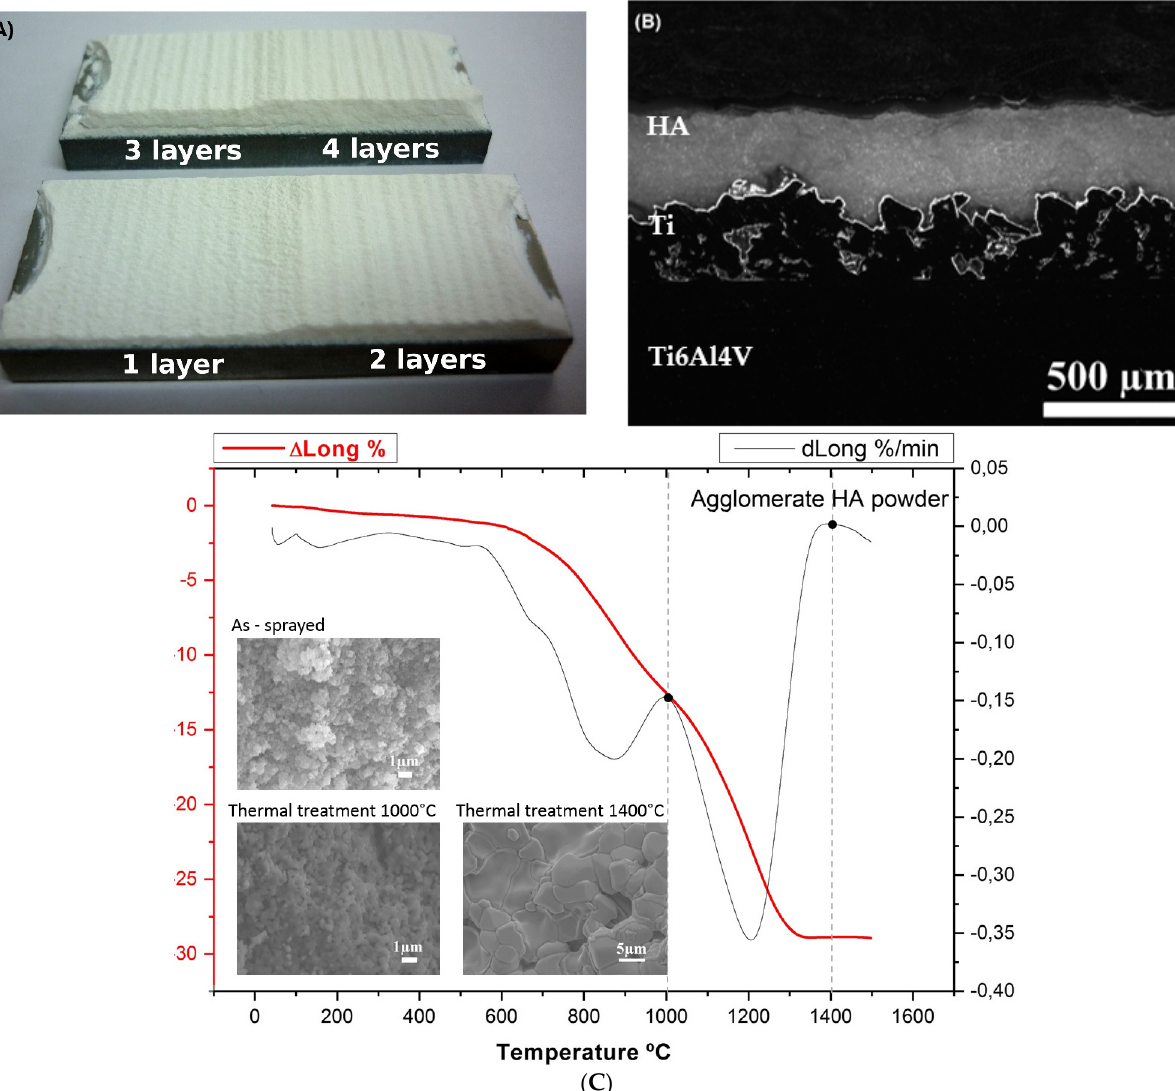
Figure 31. Macrograph ( A ), micrograph optical image ( B ) and dilatometry of HA coating ( C ) obtained by LPCS on Ti bond coat . Reprinted with permission from [292]. Copyright 2018 John Wiley and Sons.